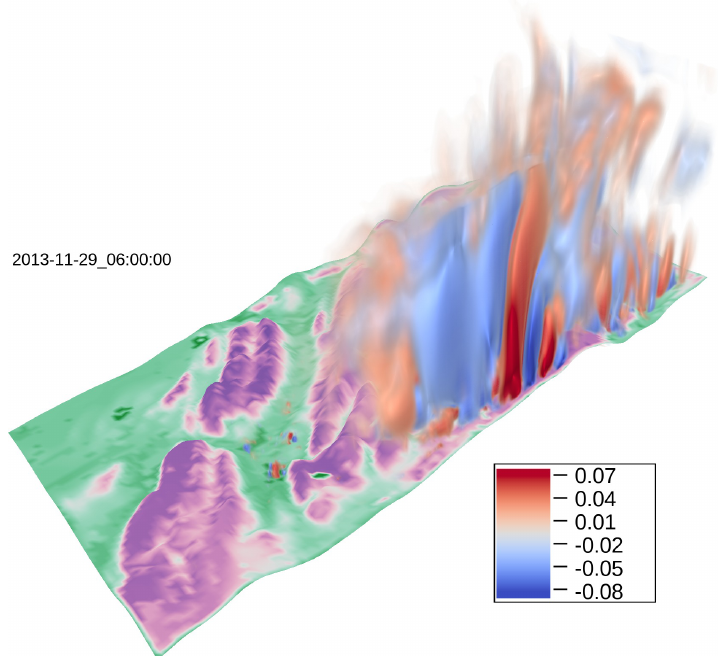
Figure 9. Perturbation of the vertical wind speed between CPL01 and CPL02 simulations m s − 1 calculated as [CPL01-CPL02] on 29 November 06:00 UTC. Orography is highlighted with the albedo from green ( ≈ 0.20 to violet ≈